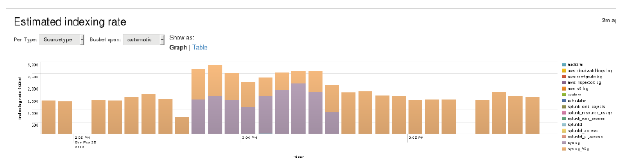
Figure 7. Splunk Virtual Machine Results